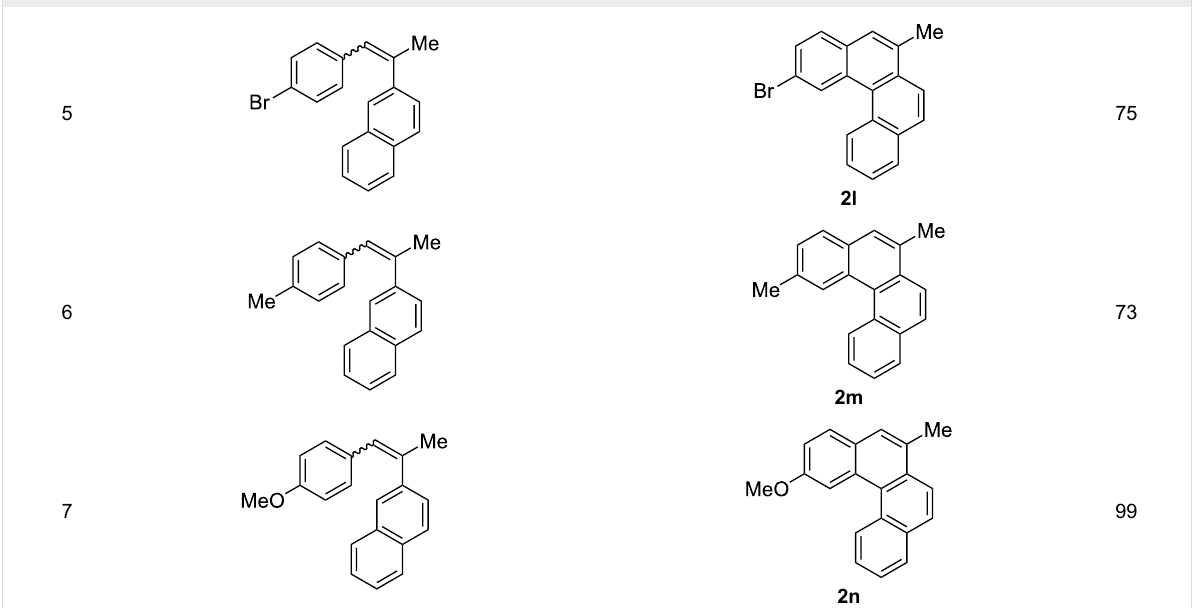
Table 4: Scope: synthesis of [4]helicenes by photocyclization in flow. (continued)